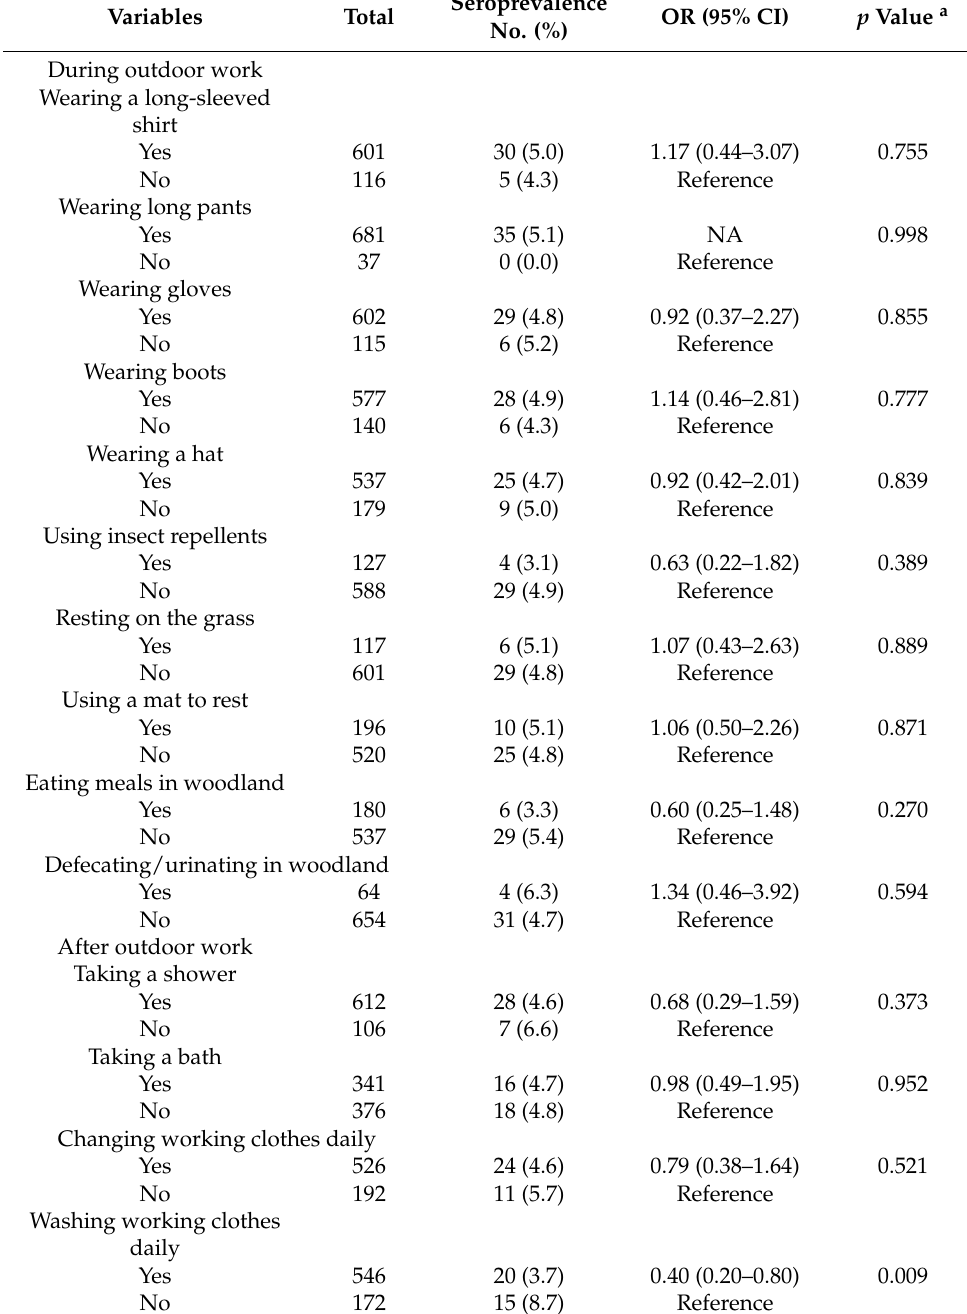
Table 4. Association between work hygiene-related factors and scrub typhus seroprevalence among National Park Office forestry workers in South